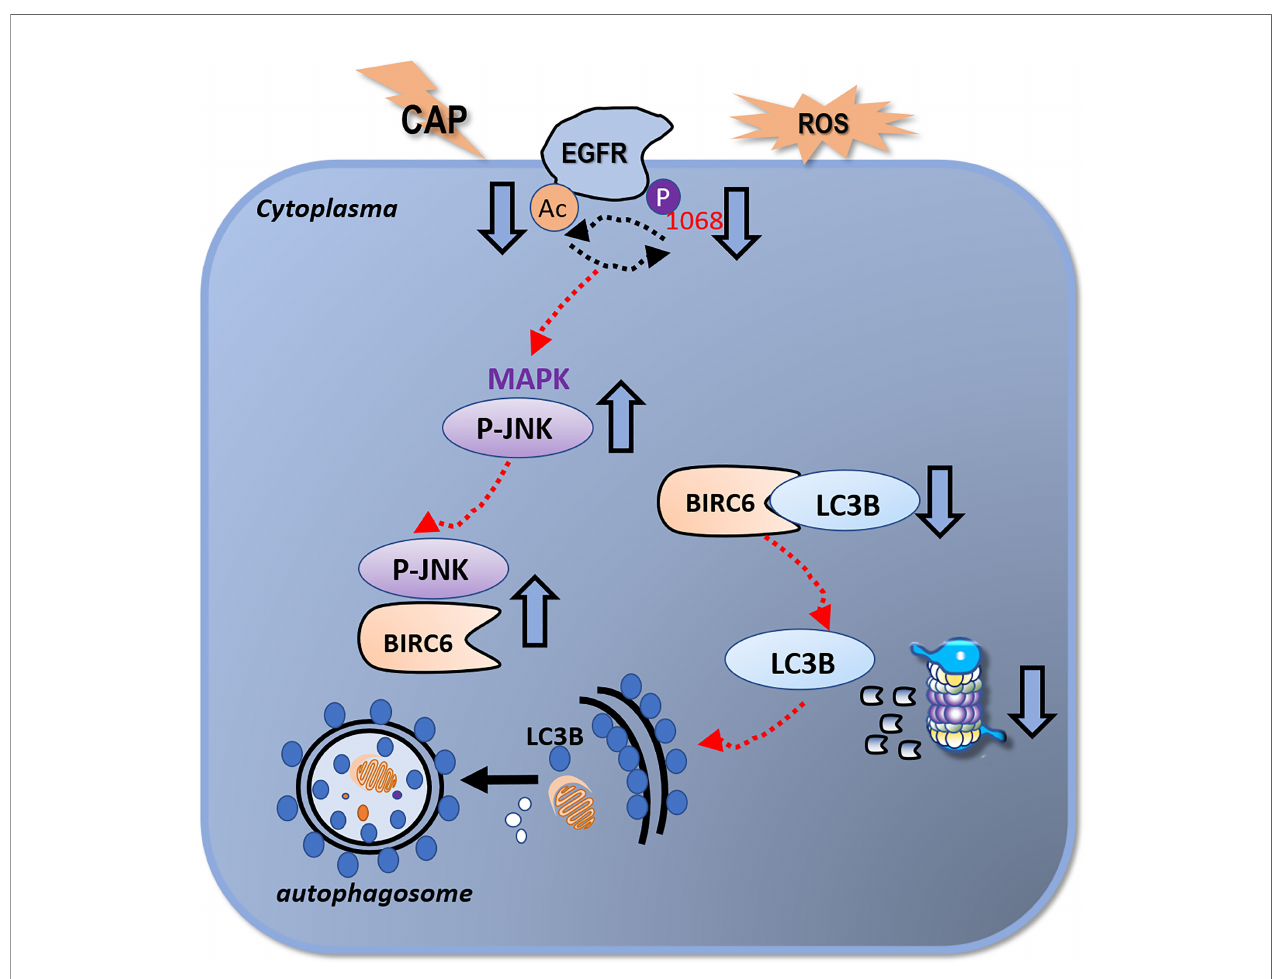
FIGURE 5 | Illustrative diagram on the mechanism of CAP in triggering autophagy in HCC cells. CAP suppresses EGFR acetylation and EGFR(Tyr1068) phosphorylation that interfere with each other and collectively lead to an elevated level of p-JNK as well as its enhanced interactions with BIRC6. This reduces the availability of BIRC6 in interacting with LC3B, which results in reduced LC3B ubiquitination and enhanced